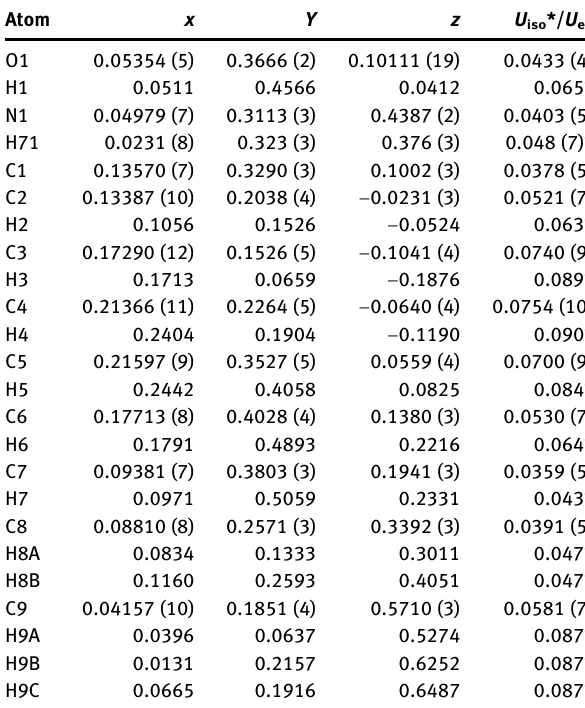
Table  : Fractional atomic coordinates and isotropic or equivalent isotropic displacement parameters (Å 